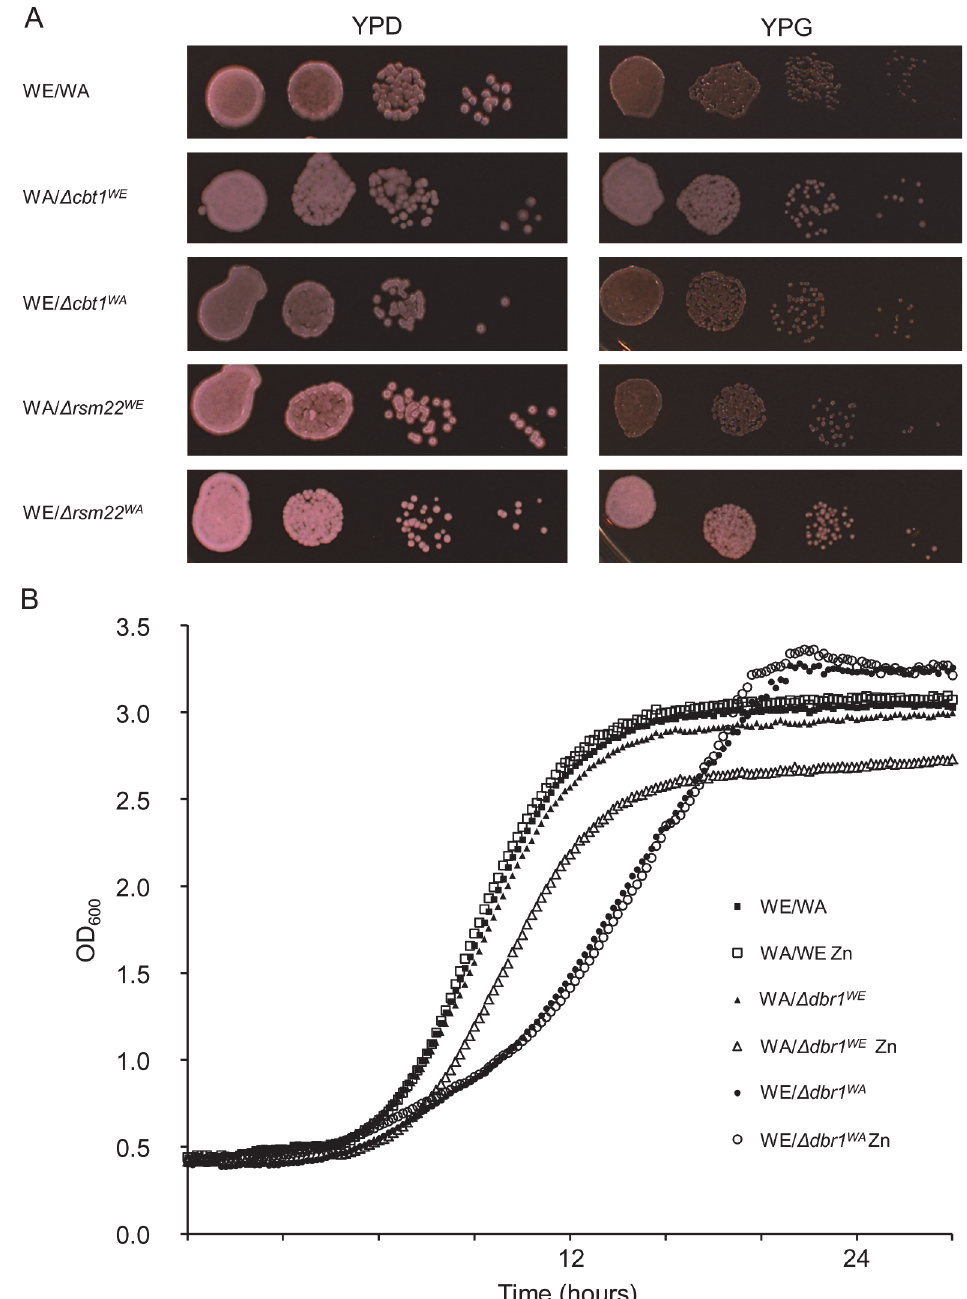
Fig 5. Phenotypic characterization of CBT1 , RSM22 , and DBR1 alleles. A) CBT1 and RSM22 alleles did not show respiratory deficiency. Serial dilutions of heterozygous and hemizygous strain cells were plated on YPD medium and YPG medium containing 2% glycerol, which were grown at 28°C for one and two days, respectively. B) The hybrid carrying DBR1 WA shows defective competitive fitness. Optical density at 600 nm (OD 600 ) was monitored every 10 min as a growth measure at 28°C of the strains in SD medium and SD medium containing 3.5 mM ZnCl 2 .